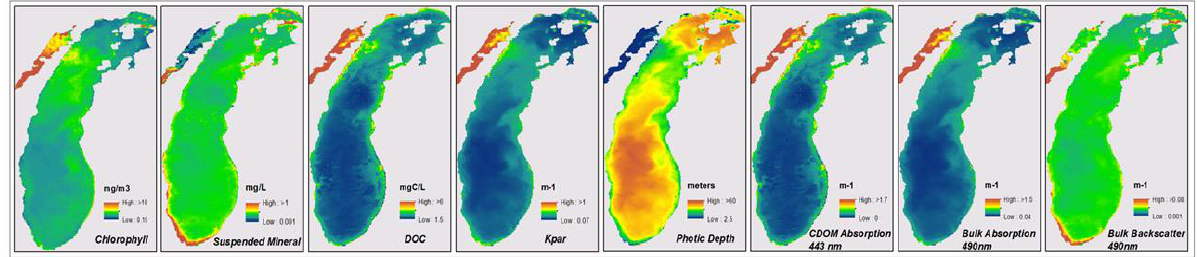
Figure 4: Monthly averaged CPA-A outputs for Lake Michigan from July